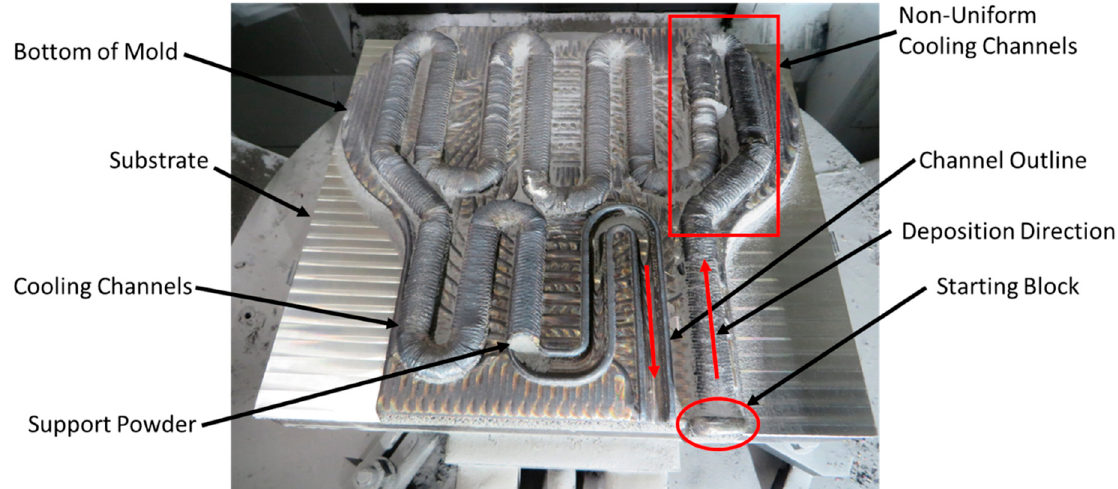
Figure 6. Deposition of mold cooling channels.